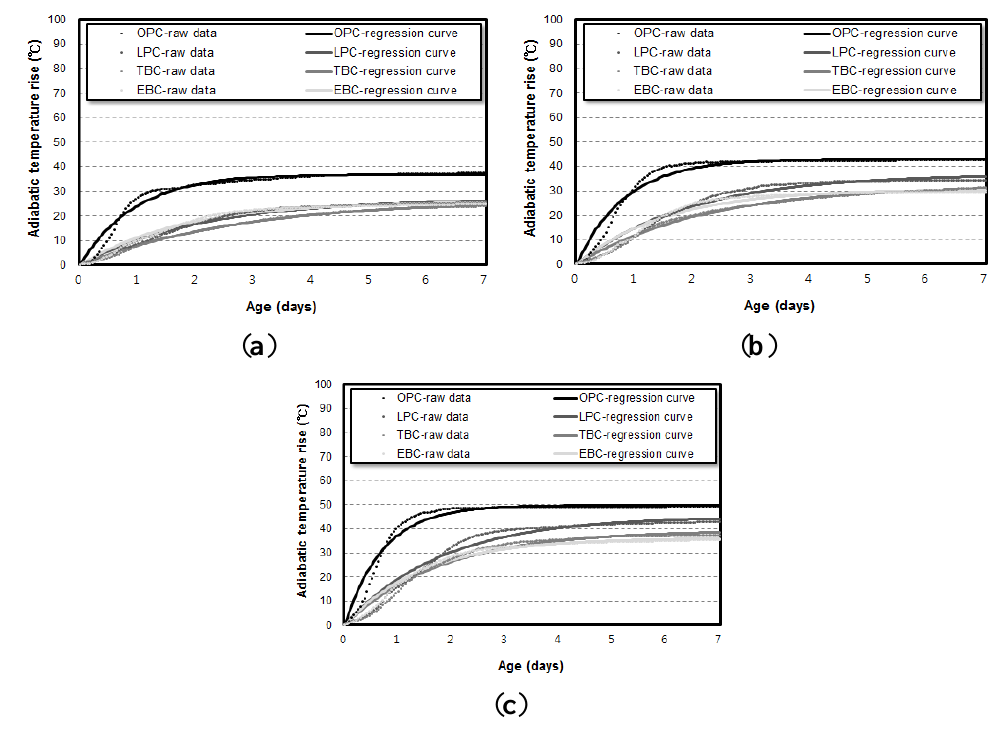
Figure 6. Amount results of the 6 L adiabatic temperature rise test depending on binder types. ( a ) Unit weight of binder: 300 kg/m 3 ; ( b ) unit weight of binder: 400 kg/m 3 ; ( c ) unit weight of binder: 500 kg/m 3 .